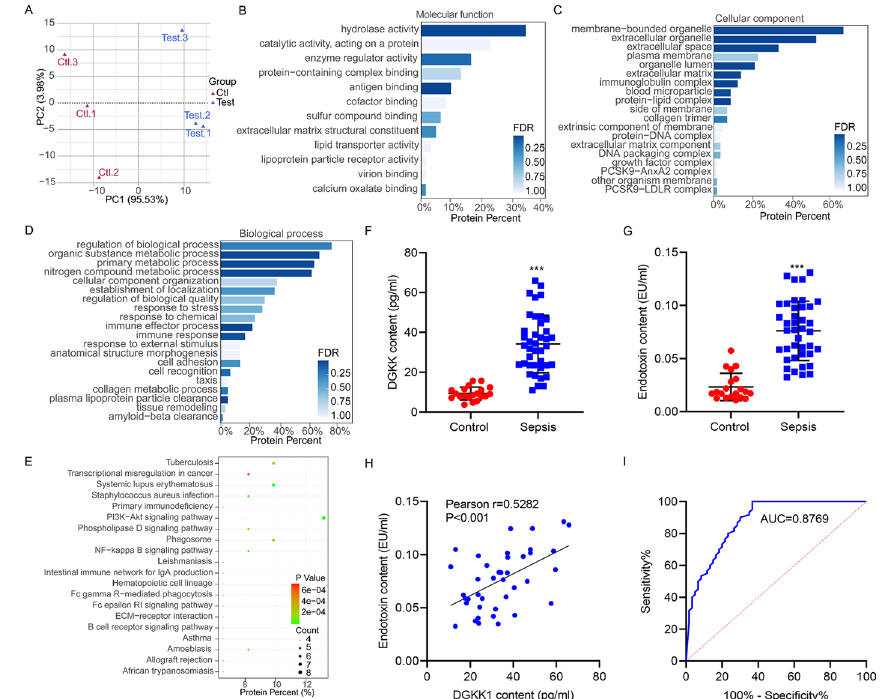
Fig. 1 Discovery of DEPs in serum EVs from patients with sepsis‑induced lung injury. A PLS‑DA of protein profiles of EVs isolated from the serum of patients with sepsis‑induced lung injury ( n 3) and healthy control = subjects ( n 3). GO analysis of 61 DEPs in the aspects of ( B ) molecular function, ( C ) cellular component, = and ( D ) biological process. E KEGG enrichment analysis of the 61 DEPs. F Isolation of serum EVs and ELISA detection of higher DGKK in patients with sepsis‑induced lung injury ( n 40) compared with healthy control = subjects ( n 20). G Higher endotoxin content in serum of patients with sepsis‑induced lung injury ( n 40) = = compared with healthy control subjects ( n 20). H Pearson correlation analysis showed positive correlation = between serum endotoxin content and exosomal DGKK level in patients with sepsis‑induced lung injury ( n 40). I ROC curve analysis indicating that exosomal DGKK content could be used to differentiate patients = with sepsis‑induced lung injury from healthy control subjects. *** P < 0.001 versus